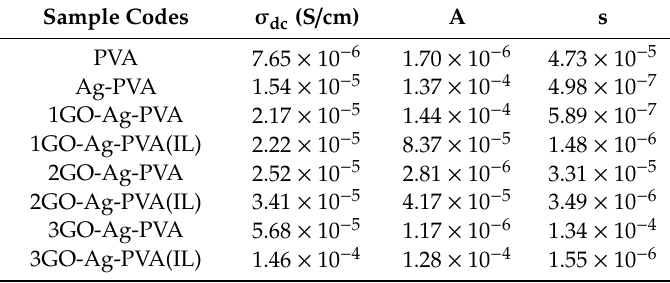
Figure 9. Schematic representation of tunneling and hopping mechanism of electrons. Table 1. DC conductivity values obtained from the power law fitting curves of the conductivity plots.